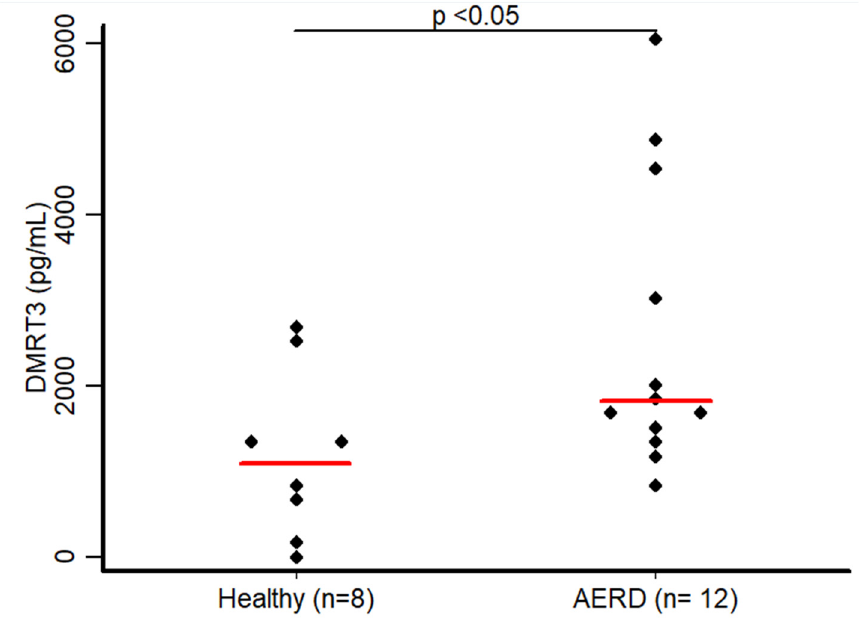
Figure 2. ELISA results are represented in this dot plot showing a significant difference in DMRT3 levels in nasal aspirates of AERD vs normal controls. Horizontal lines represent median values.